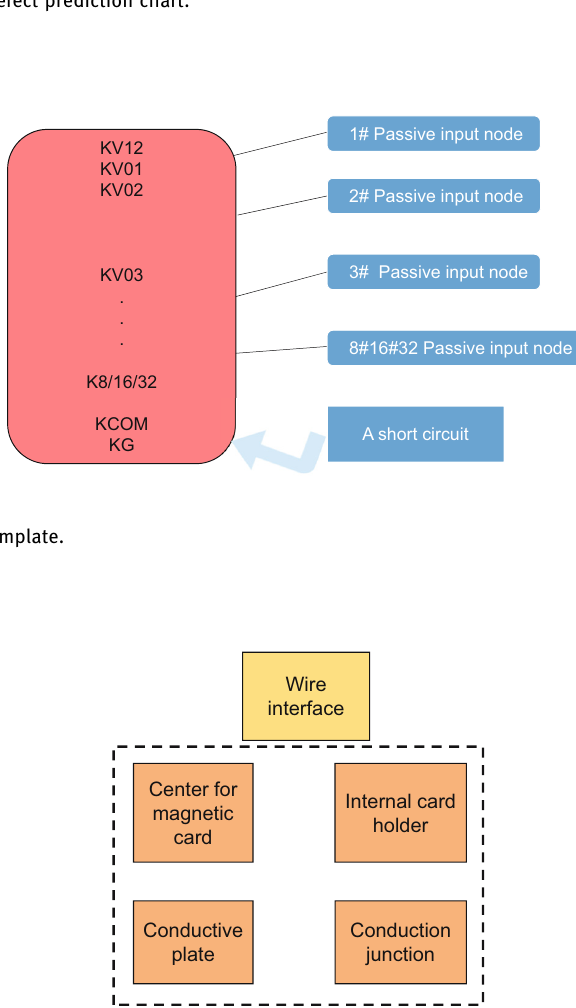
Figure 4: Data conduction chip